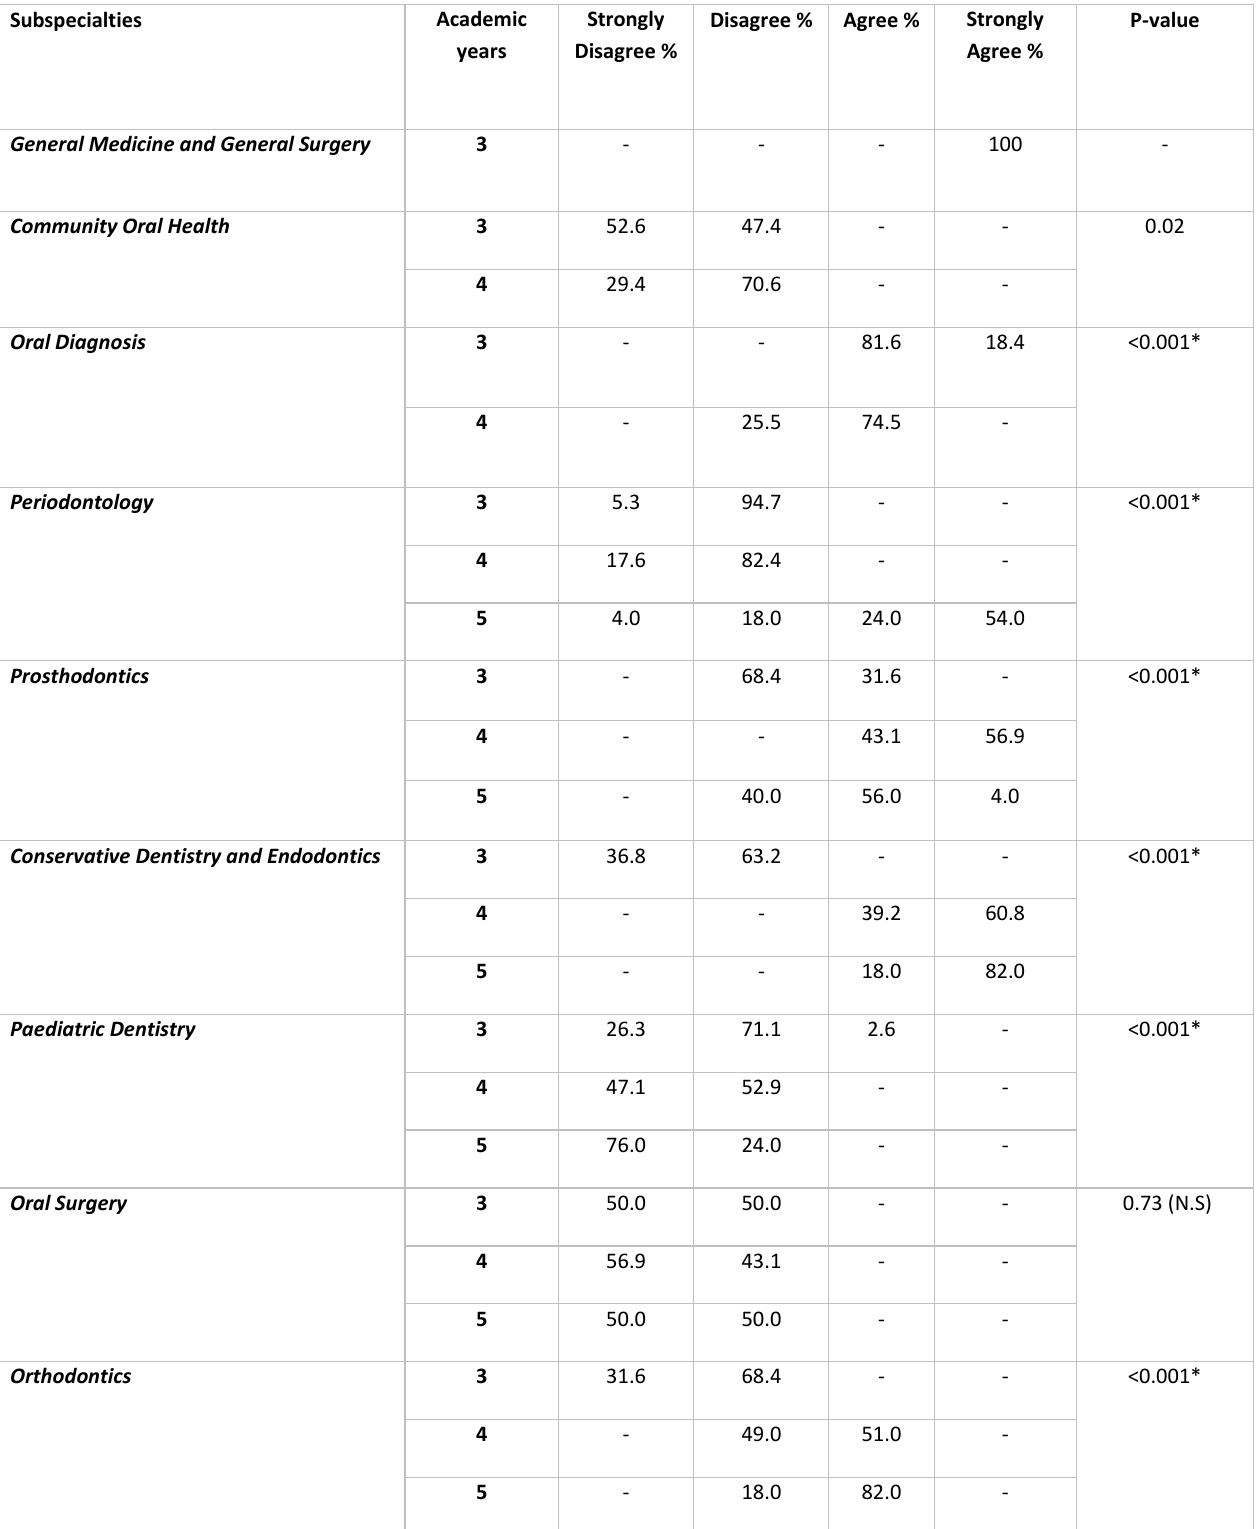
Strongly Disagree % Agree % Strongly P-value years Disagree % Agree %